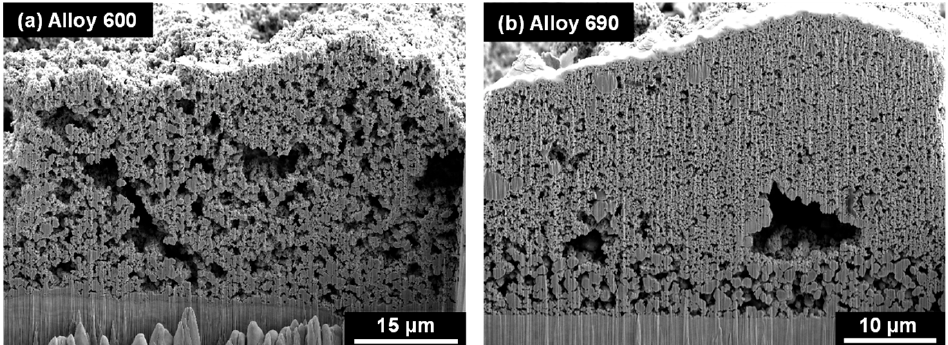
Figure 10. SEM cross-section images of magnetite deposits on two different SG tubes obtained using the FIB technique: ( a ) Alloy 600 and ( b ) Alloy 690.